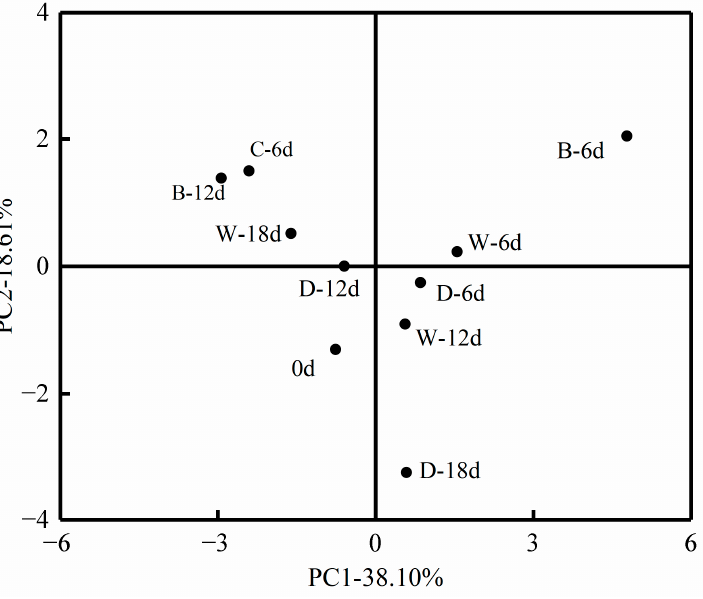
Figure 11. Principal component scores of key flavor substances in beef under different low-temperature storage methods.